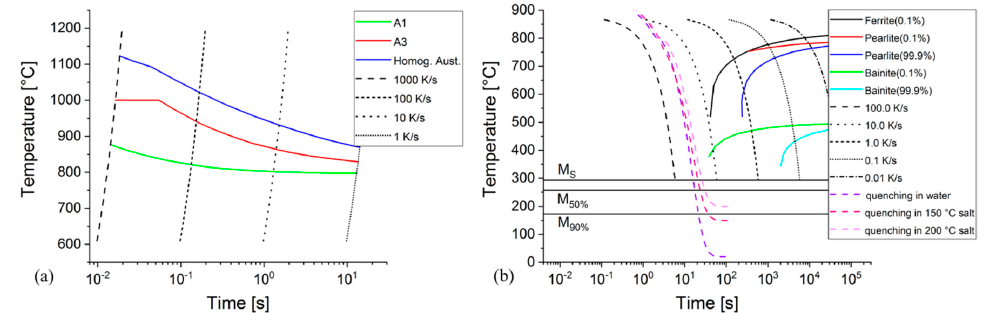
Figure 2. ( a ) Time-temperature-austenitization (TTA) and ( b ) continuous cooling transformation (CCT) diagrams, calculated using JMatPro.